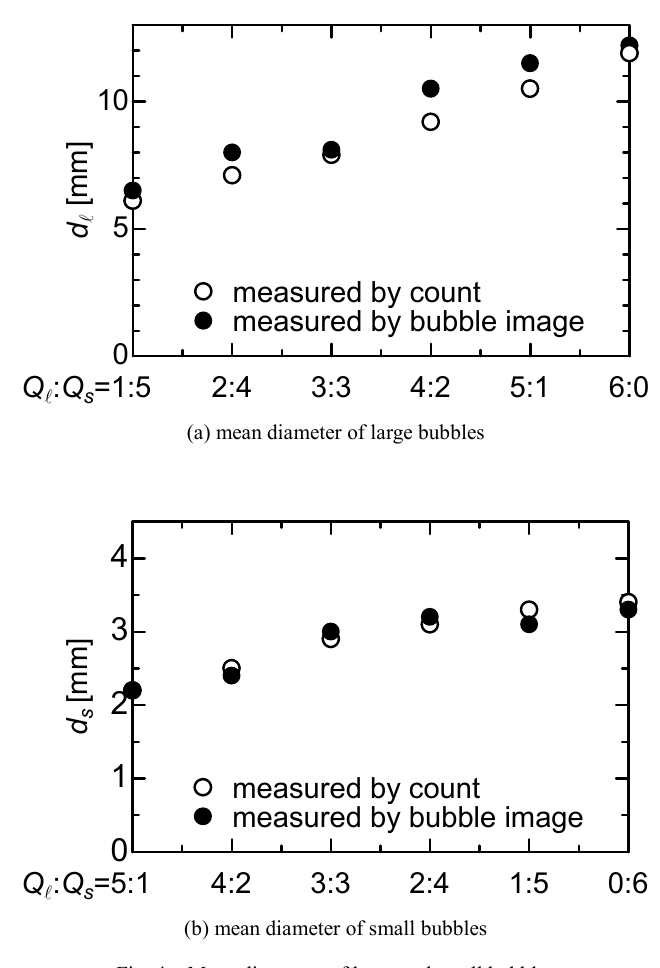
Fig. 4 Mean diameters of large and small